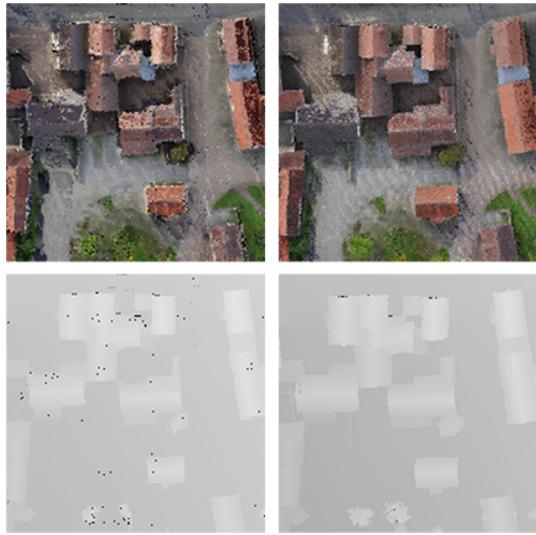
Figure 6. Comparison of the rasterized data based on conven- tional (left) and probabilistic fusion (right): Point clouds pre- sented in color (top) and as elevation